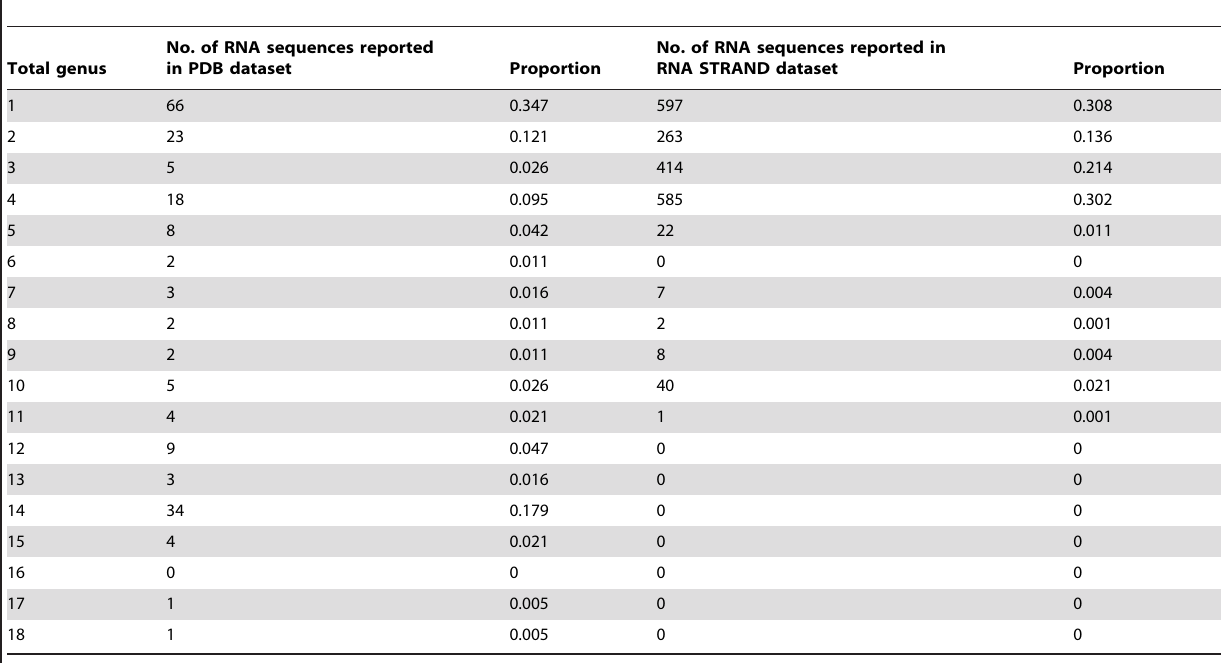
Table 5. Comparison of genus of the whole secondary structure between RNA sequences in the PDB dataset (190 sequences in total) and in the RNA STRAND dataset (1939 sequences in total).